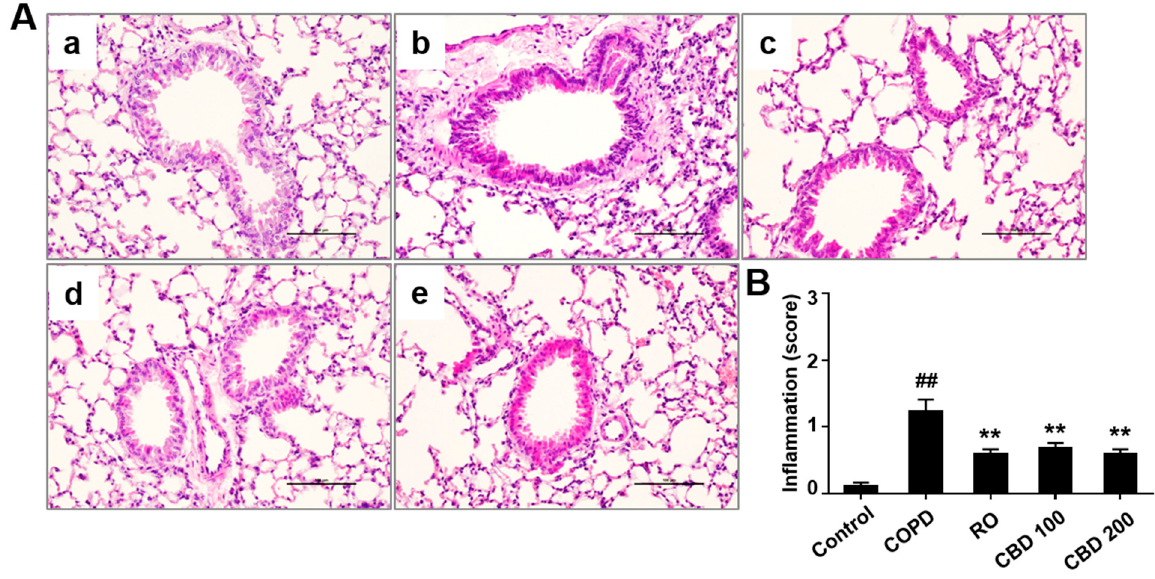
Figure 1. Effects of CBD on lung tissue histological damage. ( A ) H&E staining. ( B ) The degree of inflammation. ( a ). Control: mice instilled intratracheally with normal saline; ( b ). COPD: mice exposed to CS and LPS; ( c ). RO: mice exposed to 10 mg/kg roflumilast plus CS and LPS; ( d ). CBD 100: mice exposed to 100 mg/kg CBD plus CS and LPS; ( e ). CBD 200: mice exposed to 200 mg/kg CBD plus CS and LPS. Results are presented as means ± SEMs. ## p < 0.01 compared with the control group; ** p < 0.01 compared with the COPD group. Scale bar 100 μ m.